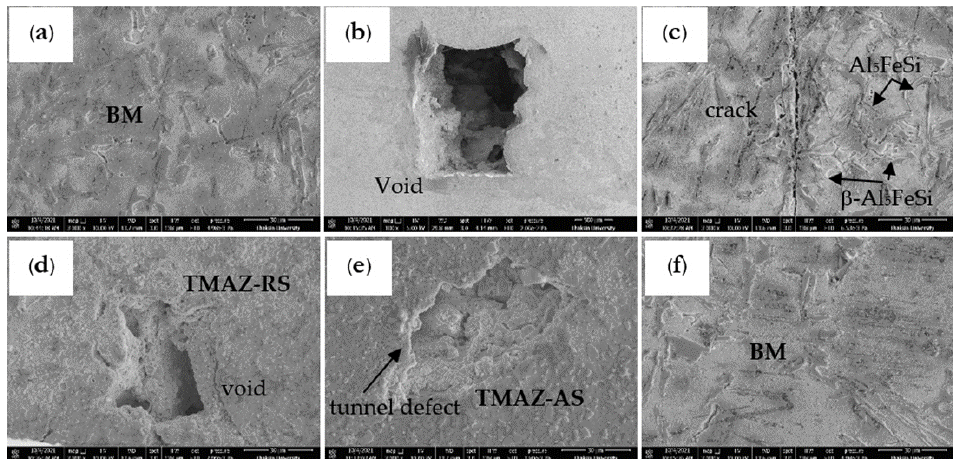
Figure 14. The characteristics of the Al 5 FeSi intermetallic compound evaluation by SEM (6000×) of the best initial experiment: ( a , f ) BM, ( b , c ) SZ, ( e ) TMAZ-AS, and ( d ) TMAZ-RS.